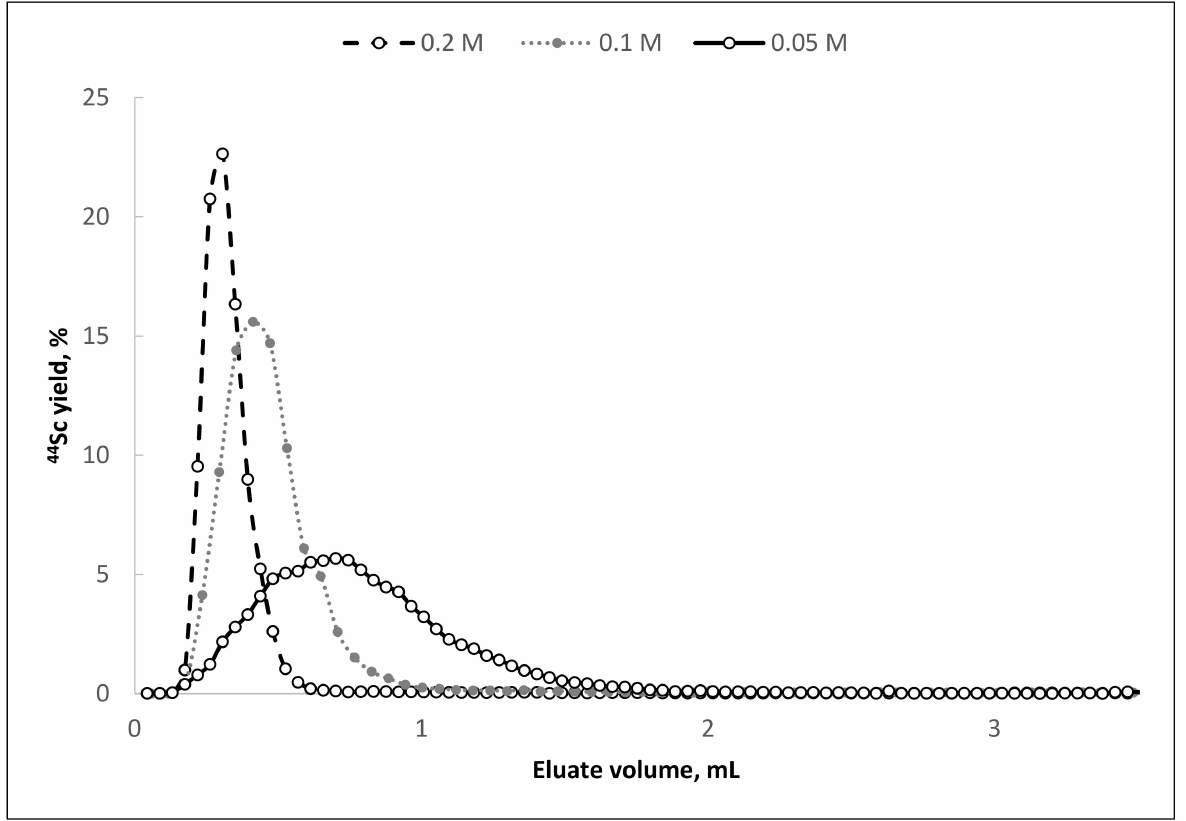
Figure 2. Elution curves of 44 Sc from TEVA resin with eluents of various HCl concentrations (oxalic acid concentration— 0.1 mol/L, flow rate—1